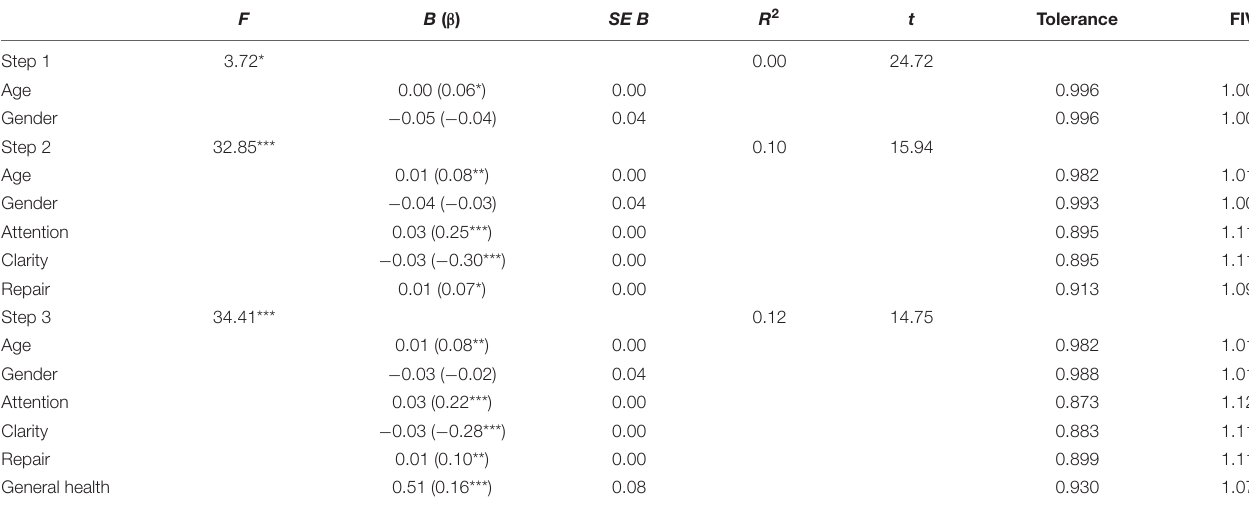
TABLE 4 | Linear regression analysis predicting compassionate fatigue from gender, age, emotional intelligence, and general health.